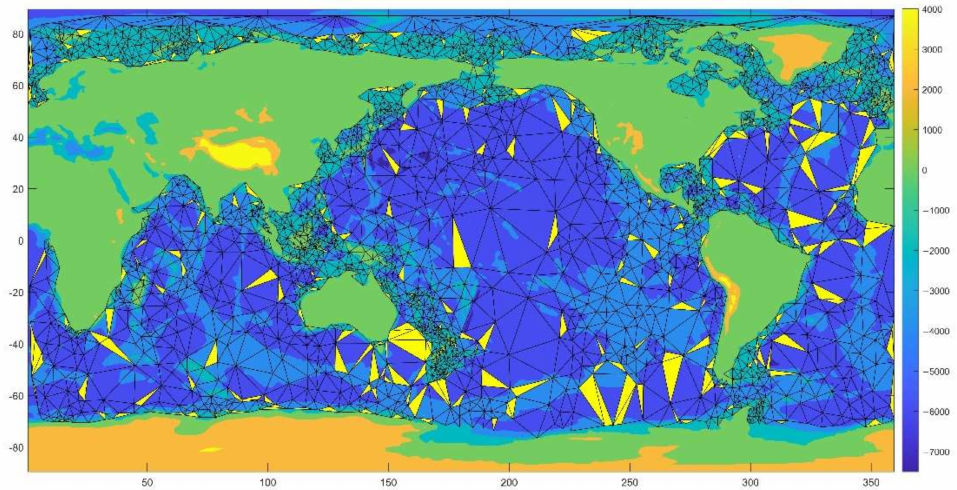
Figure 12. Global ocean unstructured grids after